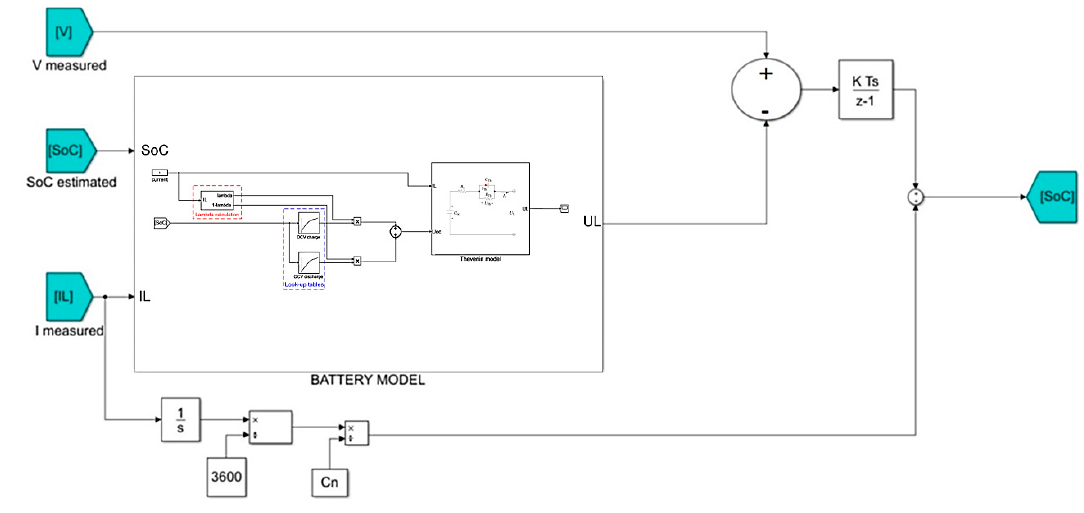
Figure 22. Mixed algorithm model (Simulink block diagram).